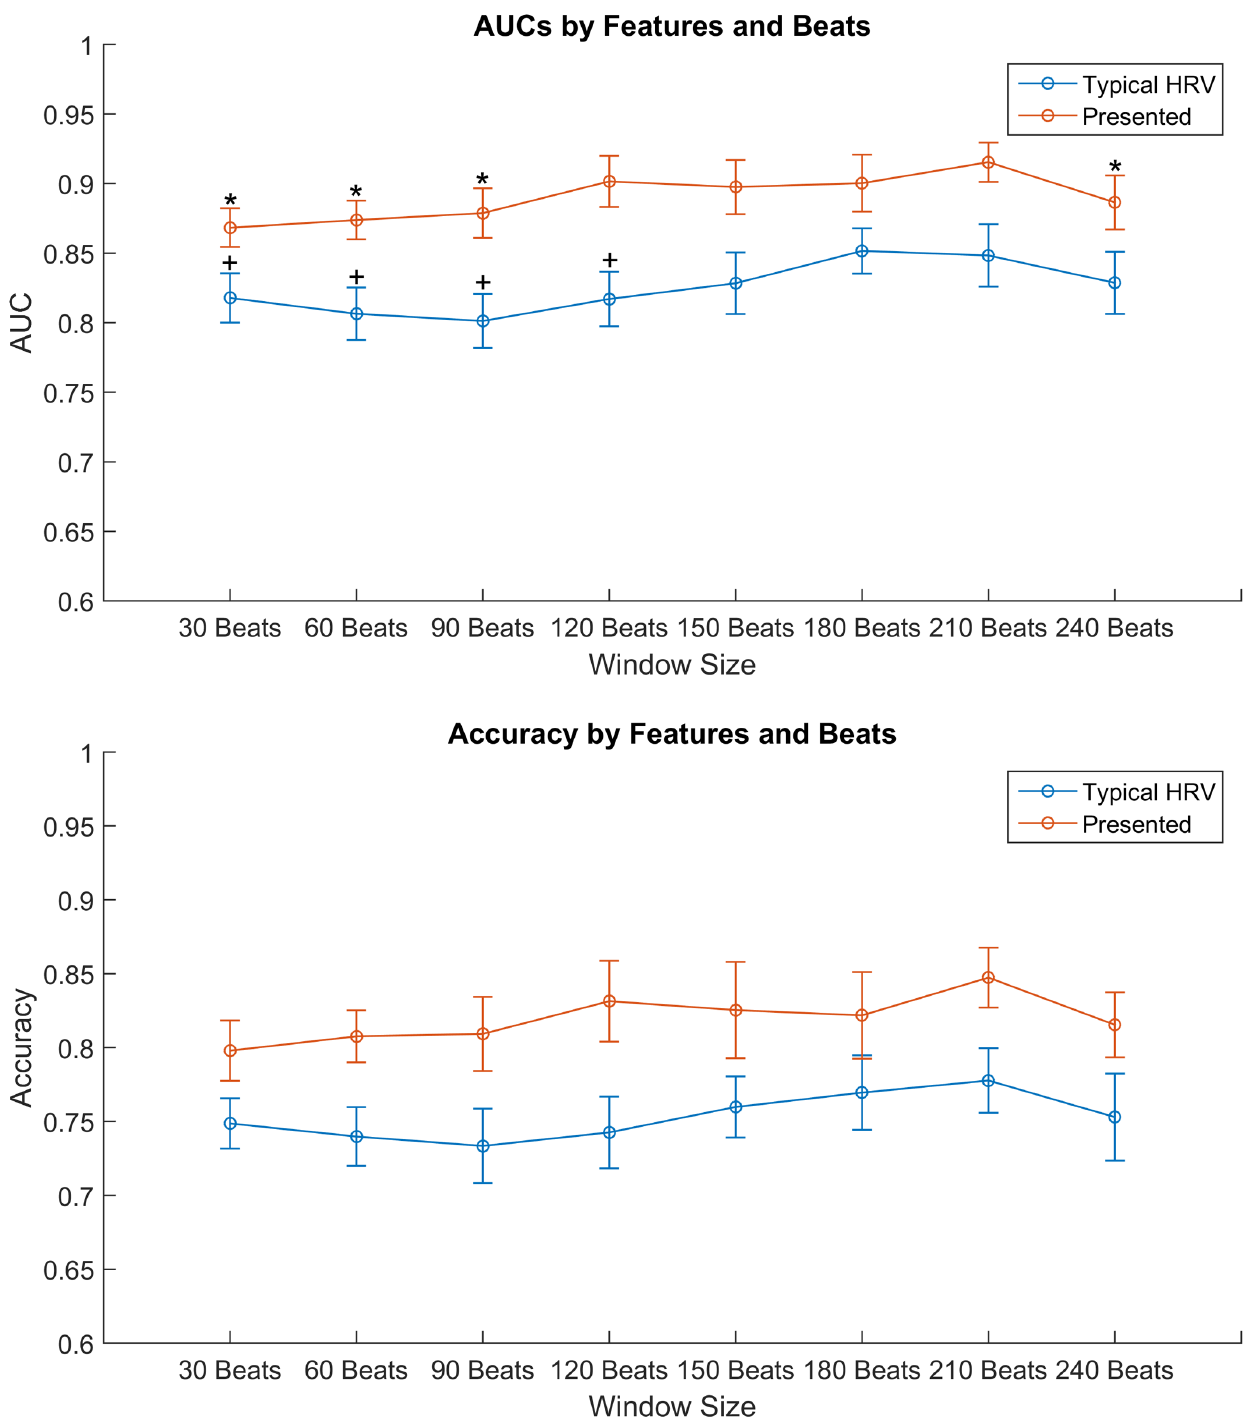
Fig 6. AUCs and Accuracies for Each Feature Set. (a) Areas under the receiver operating curve (AUCs). For the presented features, pair-wise Mann- Whitney U tests were used to compare the AUC ’ s for different window sizes to the one with the highest AUC (210-beats). The differences that are statistically significant are denoted by asterisks. The same was done for the typical HRV features and window sizes whose AUC was significantly different from the best window size (180-beats) are denoted by plus signs; (b) Accuracies averaged across all ten validation folds for each window size. Error bars represent a 95% confidence